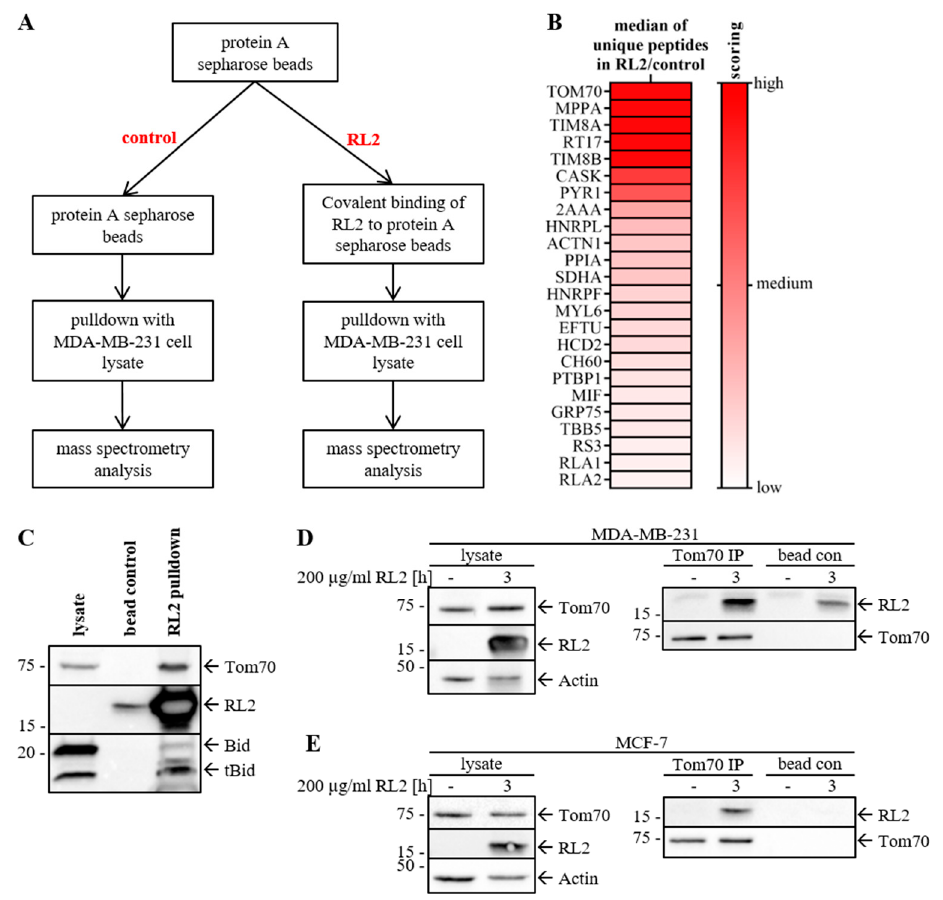
Figure 4. RL2 interacts with mitochondrial membrane protein TOM70. ( A ) Workflow for RL2-based mass spectrometry analysis. MDA-MB-231 cell lysates were incubated with RL2-coupled Protein A Sepharose beads (RL2-pulldown) or Protein A Sepharose beads (control). Precipitated proteins were identified by nanoLC-tandem mass spectrometry. ( B ) Mass spectrometry identified unique peptides for each protein. The median of the unique peptides from three independent experiments is shown for each protein and compared for RL2- and control pulldown. The scoring indicates the increase in unique peptides identified. ( C ) RL2-pulldown precipitates were analyzed by Western Blot and probed for indicated proteins. ( D ) MDA-MB-231 and ( E ) MCF-7 cells were treated with 200 µg/mL RL2 as indicated. TOM70 immunoprecipitation (TOM70 IP) was performed with TOMM70A antibody or bead-only control and probed for indicated proteins by Western Blot. One representative experiment